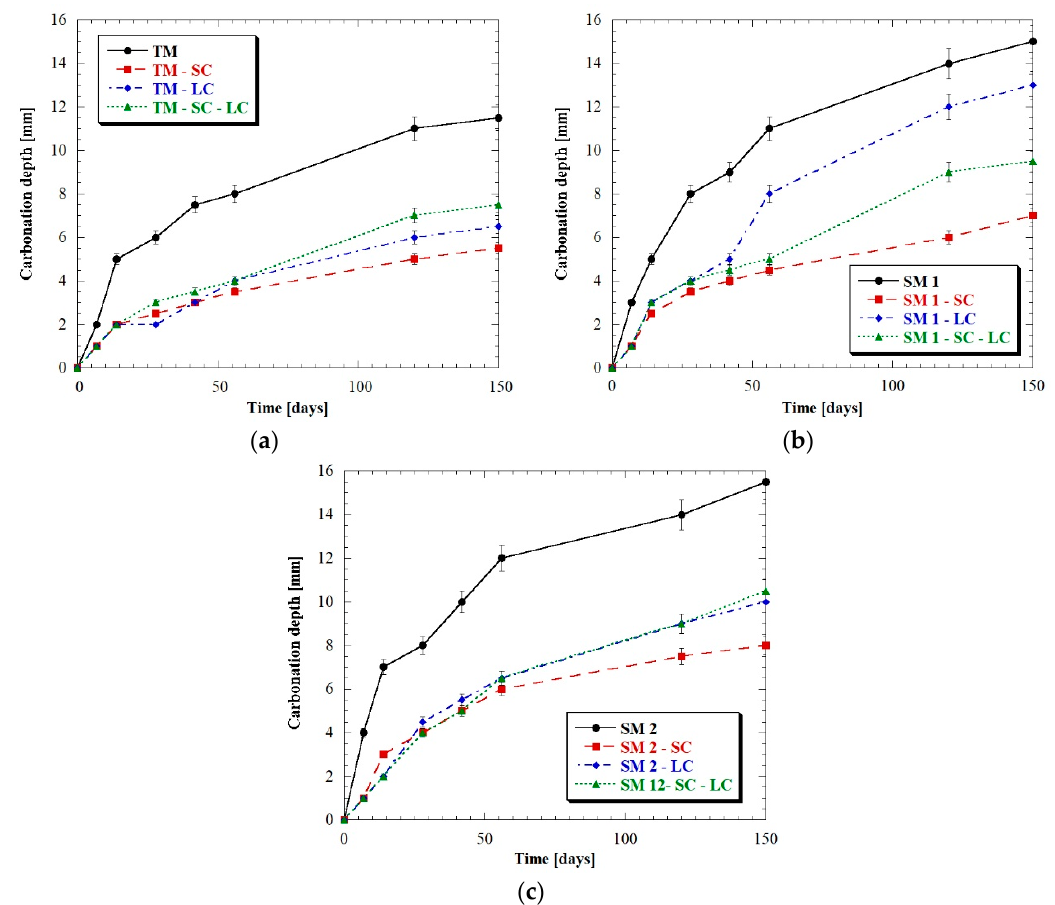
Figure 7. Carbonation of mortar ( a ) TM, ( b ) SM1 and ( c ) SM2 with different admixtures.